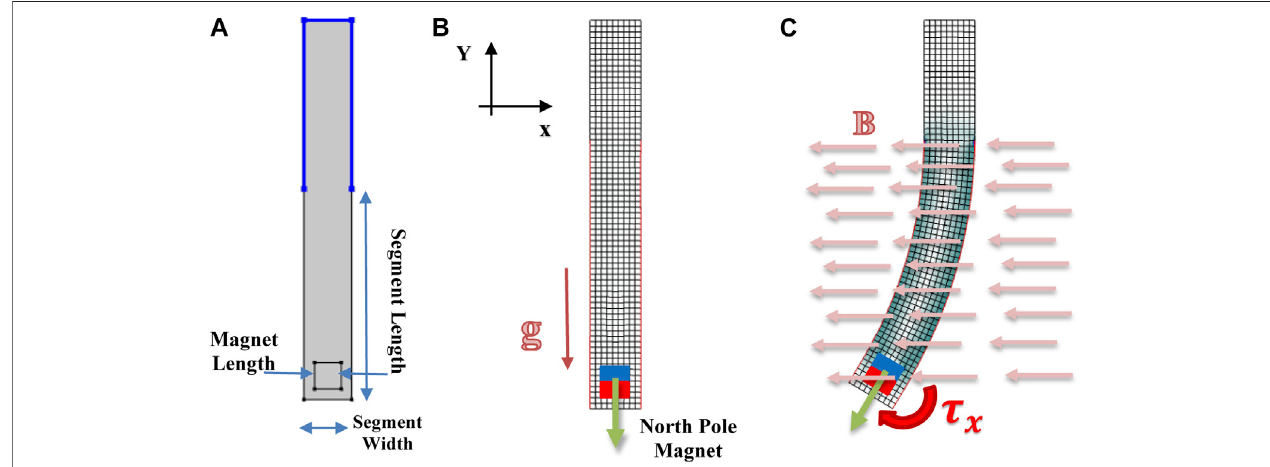
FIGURE2| Simulatedrepresentation: (A) geometryofthesampleisshown; (B) meshusedfortheFEMsimulation,thedirectionofthemagnetic fi eld,aswellasthe magnetization direction M, are shown; (C) an example simulation result is also shown.